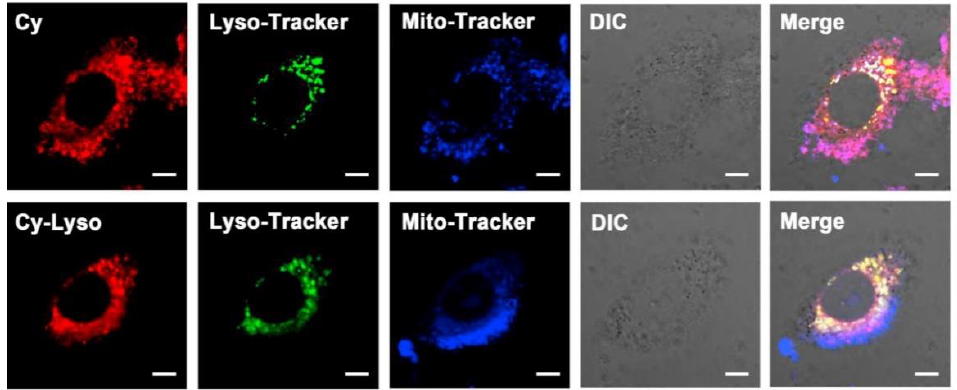
Figure 16. Confocal microscopy of IR-780 (Cy; top) and dye 80 (Cy-Lyso; bottom) in A549 cells [33]. Red staining shows probe 80 excited at 639 nm. Green staining shows Lyso-Tracker ( λ ex = 555 nm). Blue staining shows Mito-Tracker ( λ ex = 488 nm). Differential interference contrast (DIC) microscopy and merged images. Concentrations of 1 μM for each. Figure used with permission from [ 33]. Copyright 2020 Elsevier.